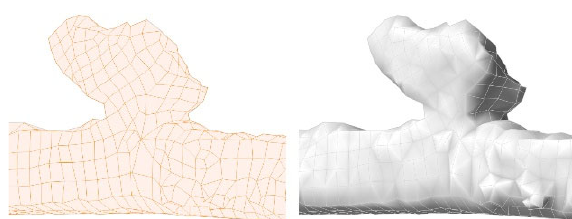
Figure 6. Piece of the tunnel 13 model after re-topology process. Wireframe (left) and solid view